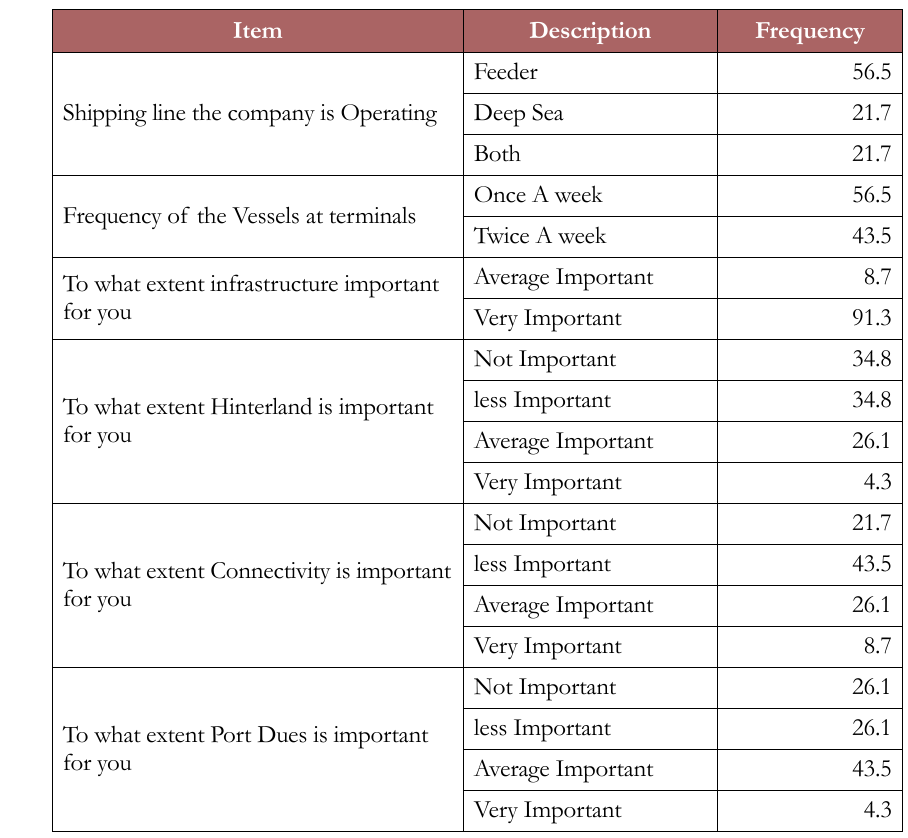
Table 3. Respondents’ Profile